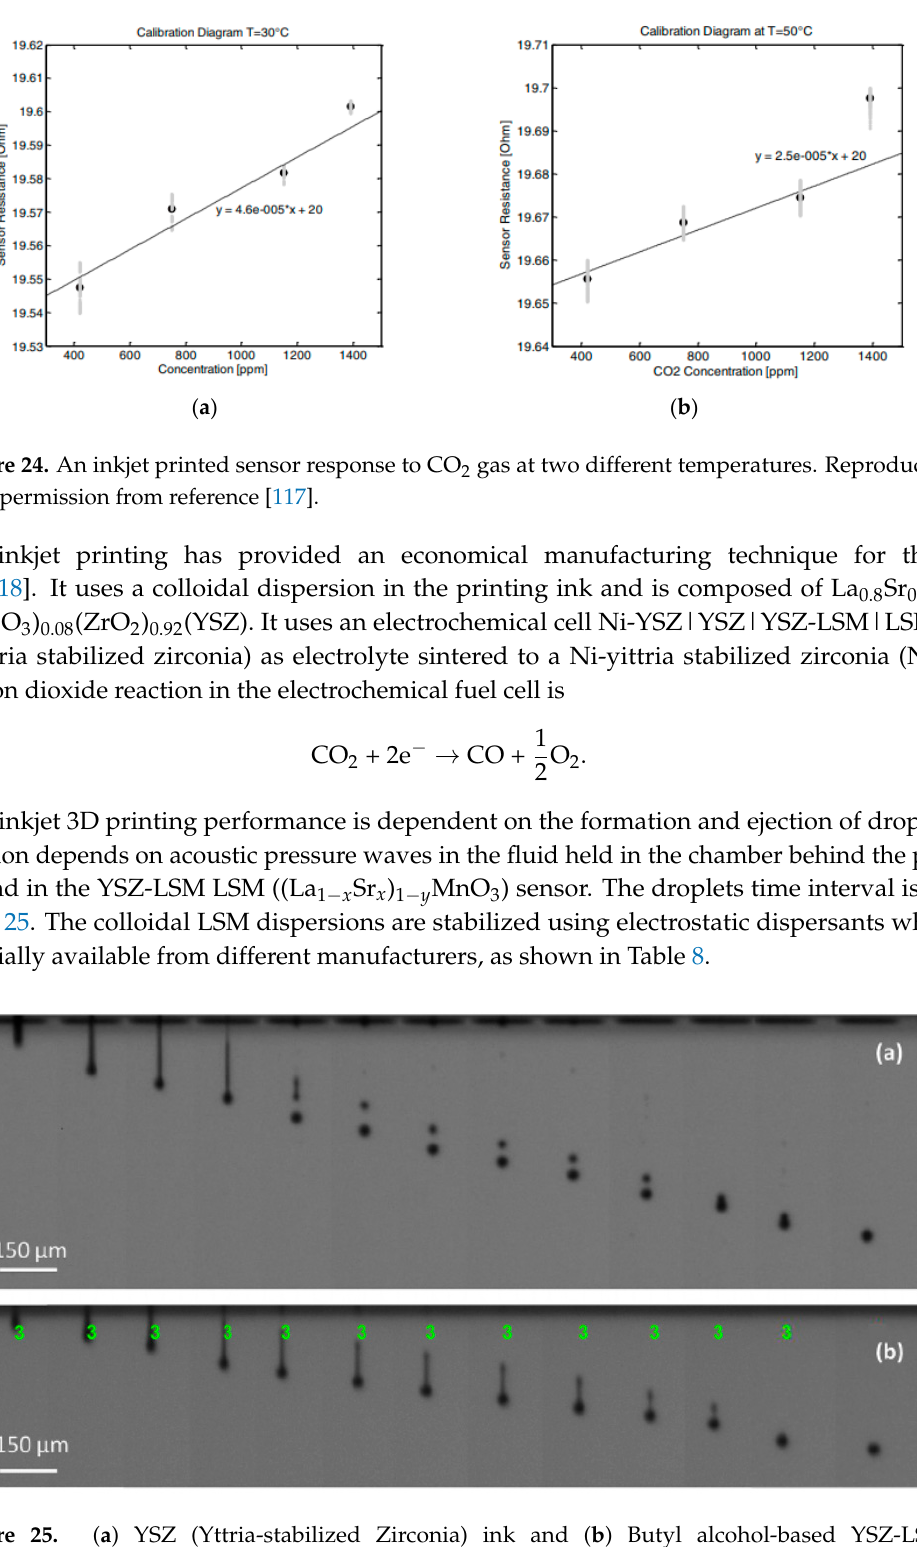
Figure 25. ( a ) YSZ (Yttria-stabilized Zirconia) ink and ( b ) Butyl alcohol-based YSZ-LSM ((La 1 − x Sr x ) 1 − y MnO 3 ink droplets from a single nozzle, with time intervals of 10 μ s and 5 μ s, respectively. The nozzle number (“3”) of the printhead is shown in ( b ). Reproduced with permission from Reference [118].